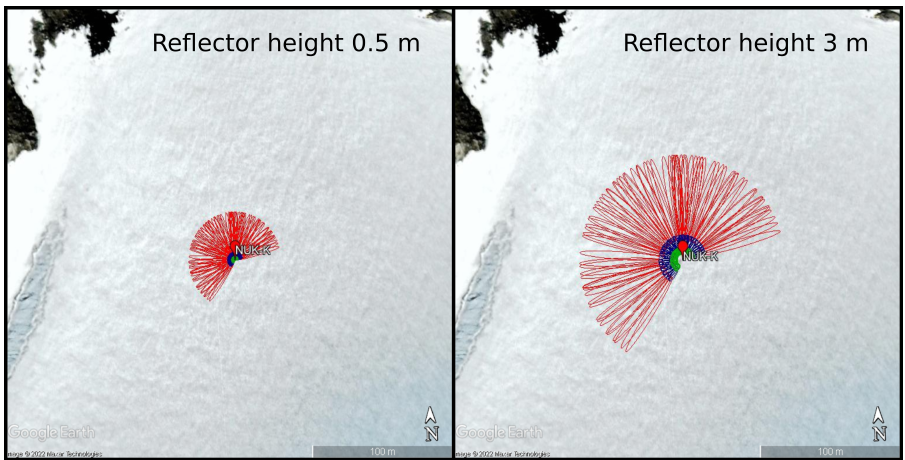
Figure 3. Reflection zones at NUK-K for a reflector height of 0.5 and 3 m at three satellite elevation angles. Red: 5 degree elevation, blue: 15 degree elevation and green: 25 degree